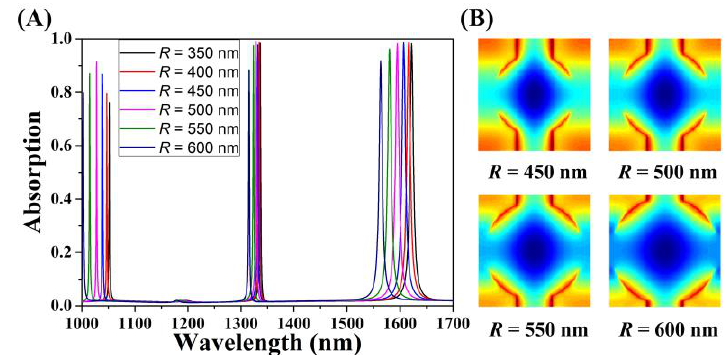
Figure 7. Changes in absorption while varying the radius R of the absorber structure and keeping the other parameters unchanged. ( A ) Optical absorption when R increased from 350 nm to 600 nm. ( B ) The electric field diagram for the graphene layer with varying radius R .